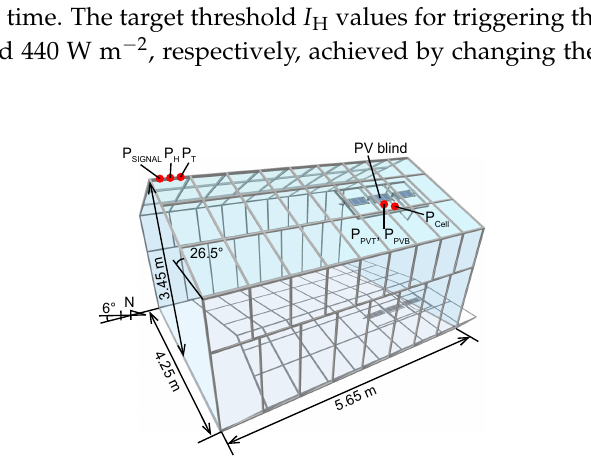
Figure 5. The PV blind installed underneath the greenhouse glass roof facing the eastern sky.